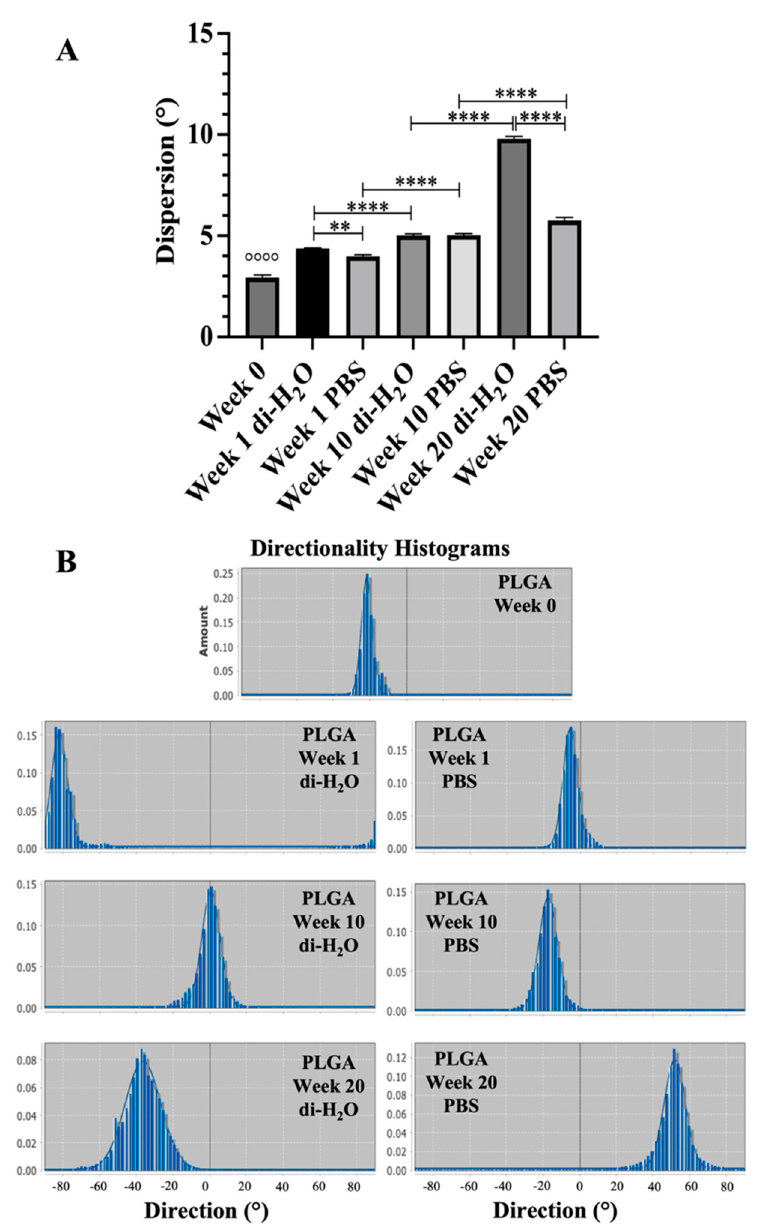
Figure 2. ( A ) The histogram shows the changes in fiber alignment of week 0 and electrospun PLGA scaffolds throughout 20 weeks of degradation under both di-H 2 O and PBS conditions. ◦◦◦◦ sta- tistically significant between the different studied groups compared to PLGA week 0 ( p < 0.0001). ** and **** statistically significant between the degraded PLGA scaffolds ( p < 0.01 and p < 0.0001, respectively). ( B ) Representative histograms of each sample showing the angle distribution on the electrospun PLGA scaffolds throughout the degradation